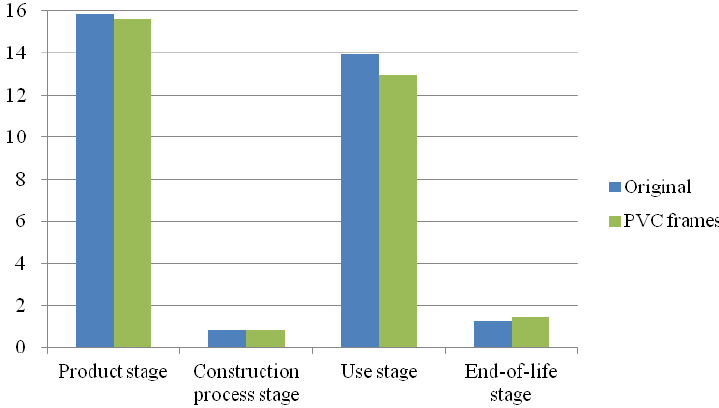
Figure 6. Graphical comparison of the global warming potential impact